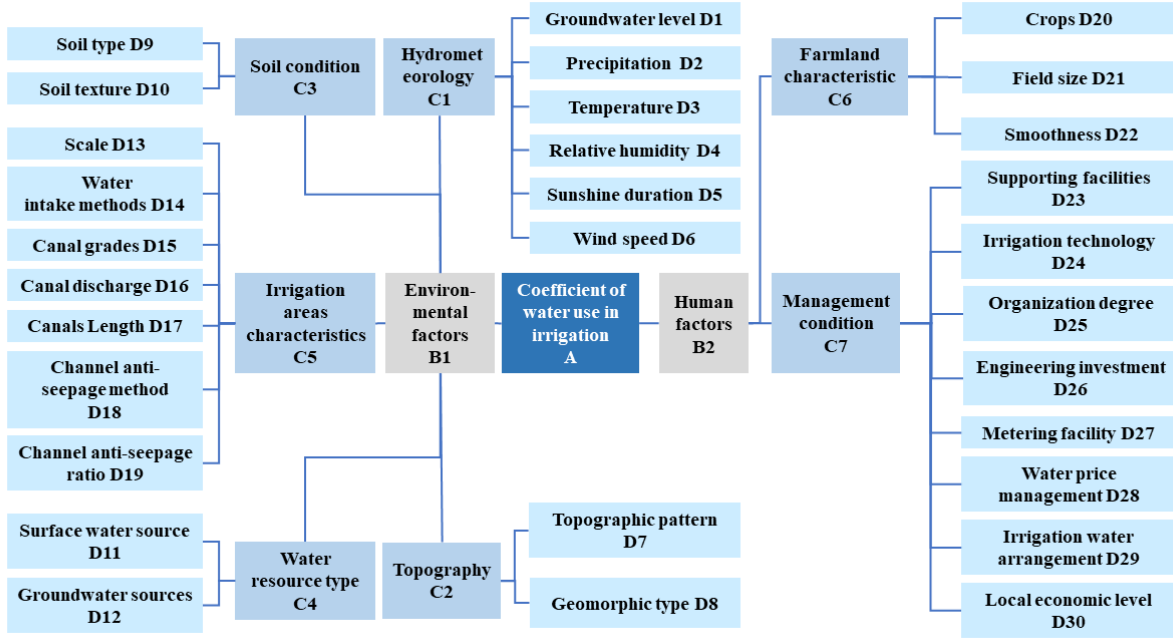
Figure 2. The water path of irrigation system in the study area.